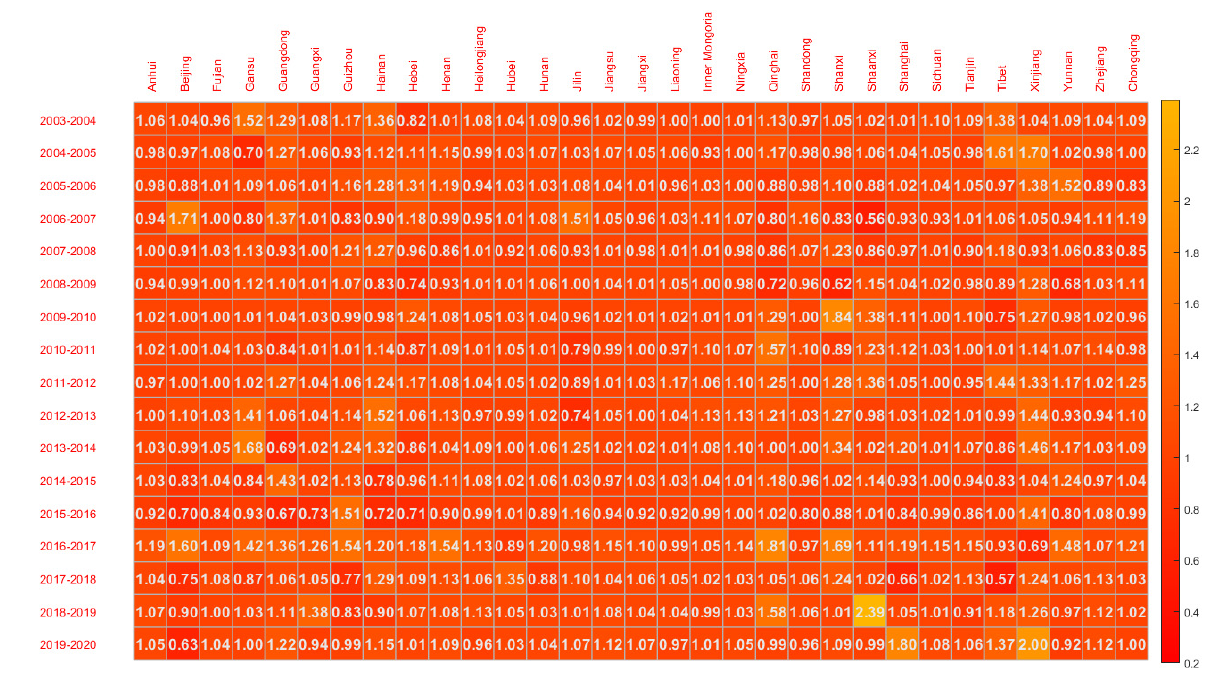
Figure 2. China’s GTFP of freshwater aquaculture, 2004–2020.